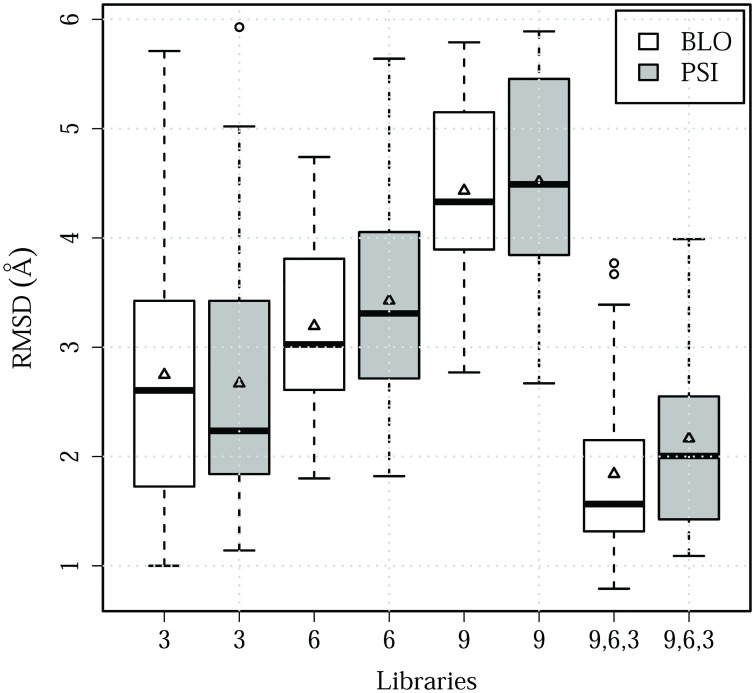
RMSDs of the best models.Models were built from a combination of different fragments length (9, 6 and 3-residues long) and scores (BLOSUM62, shown in white; PSIPRED+BLOSUM62, in gray).